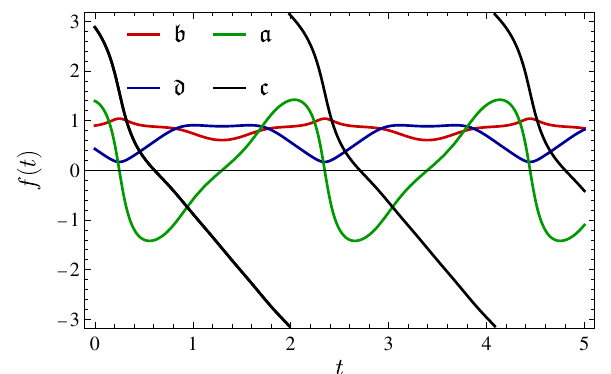
FIG. 8. Time dependence of the MPS parameters that define the trajectory within the MPS manifold as computed from TDVP for the TLFIM model with J = 1, h x = 1, and h z = 0.4. Note that the quick change in parameters a and c at t ≈ 0.25 + kt 0 ; k ∈ Z corresponds to the peaks in the driving parameters observed in Fig. 5(a) in the main text.